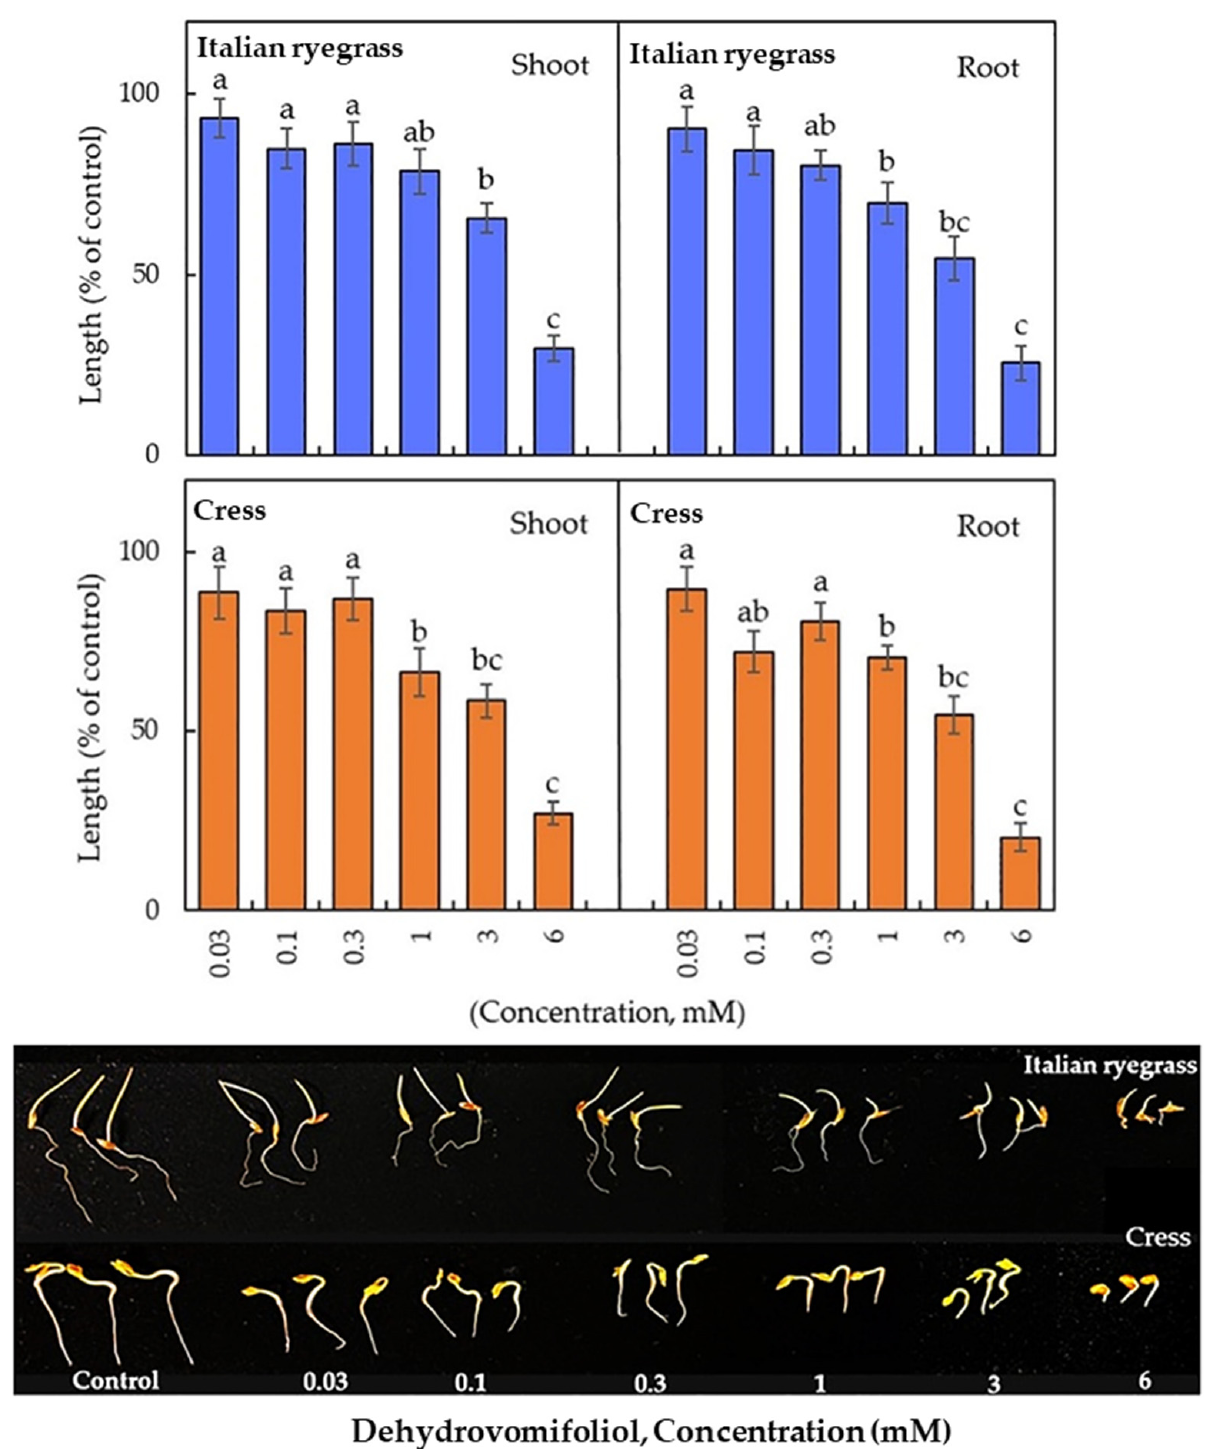
Figure 5. Effect of dehydrovomifoliol isolated from the Dregea volubilis leaf extracts on the seedling growth of Italian ryegrass and cress. The bars on each experiment express the mean ± SE with three replicates ( n = 30). The different letters indicate significant differences among the treatments (Tukey’s HSD, p < 0.05).